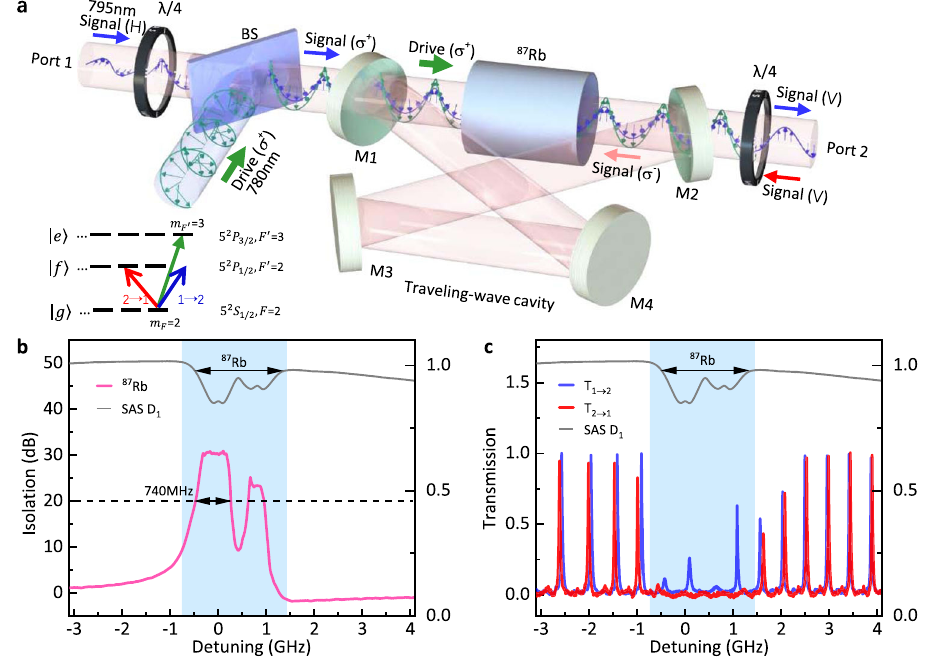
Fig. 2 Experimental observation of the magnetic-free non-reciprocity in an atom ensemble. a Experimental setup with a traveling-wave cavity, comprising of four mirrors (M1-M4) with a Rb vapor cell inside. The linearly polarized (H: horizontal polarization, V: vertical polarization) input signal from port 1(2) is converted to σ + ( σ − ) polarization by quarter waveplates ( λ /4). A drive laser in σ + polarization is coupled into the cavity through a beam splitter (BS) of port 1. Therefore, the circular birefringence or dichroism leads to non-reciprocal transmission of the whole device system. The inset diagram shows the energy levels of Rb atom, with the arrows representing the drive laser (green), the forward signal laser from port 1 (blue) and the backward signal laser from port 2 (red). b The spectrum of broadband isolation by hot atom ensemble due to optically-induced magnetization, based on the setup in a without the cavity. A maximum isolation ratio of 30 : 3 þ 0 : 3 (cid:2) dB is observed for 87 Rb and the corresponding 20 dB-isolation (dashed line) bandwidth is 740 MHz. 0 : 2 Here, the drive power ( P d ) is about 130 mW while the signal power ( P s ) is about 1 μ W. c Typical transmission spectra for the cavity setup, with P d = 45 mW and P s = 1 μ W. The gray lines is a reference saturated absorption spectrum (SAS) of 87 Rb D1 line, and the zero frequency detuning corresponds to the transition j 5 2 S 1 = 2 ; F ¼ 2 i ! j 5 2 P 1 = 2 ; F 0 ¼ 1 i . The blue shadow indicates the absorptive region that exhibits circular dichroism, and the region outside the shadow shows mode splitting due to circular